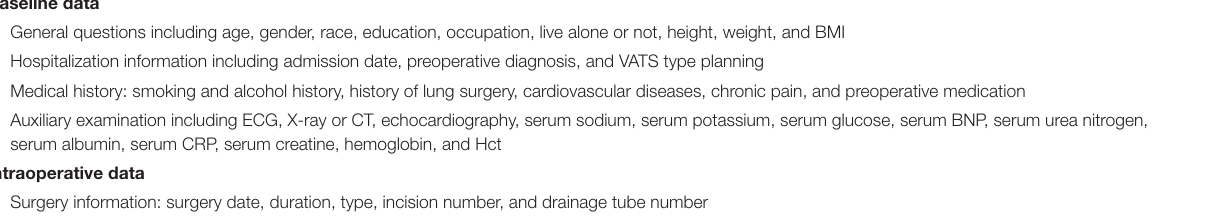
TABLE 1 | Data collection throughout the